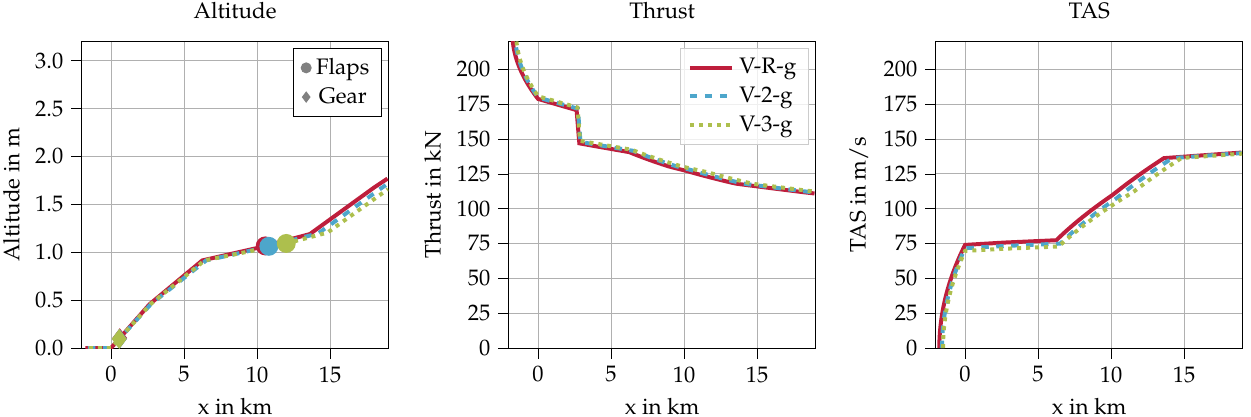
Figure 10. Departure trajectories: new engine option (BPR =